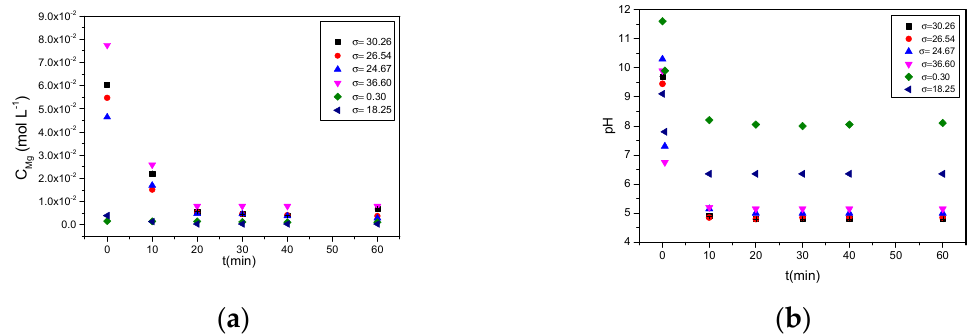
Figure 5. Precipitation of struvite from supersaturated solutions prepared according to method B